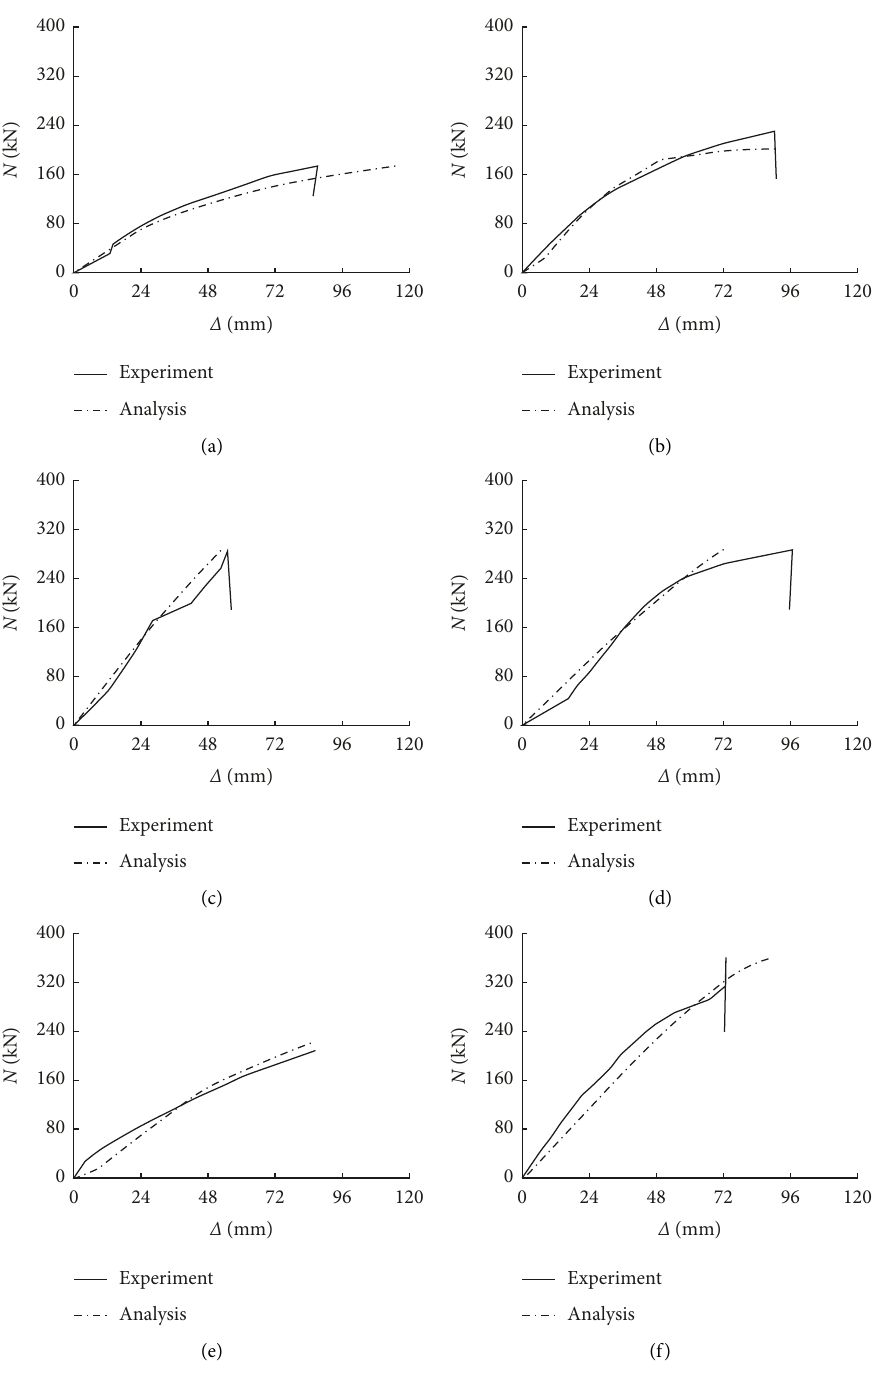
Figure 8: Comparisonofload-displacementcurvesbetweentestandnumericalanalysis:(a)SY-1;(b)SY-2;(c)SY-3;(d)SY-4;(e)SY-5;(f)SY-6.